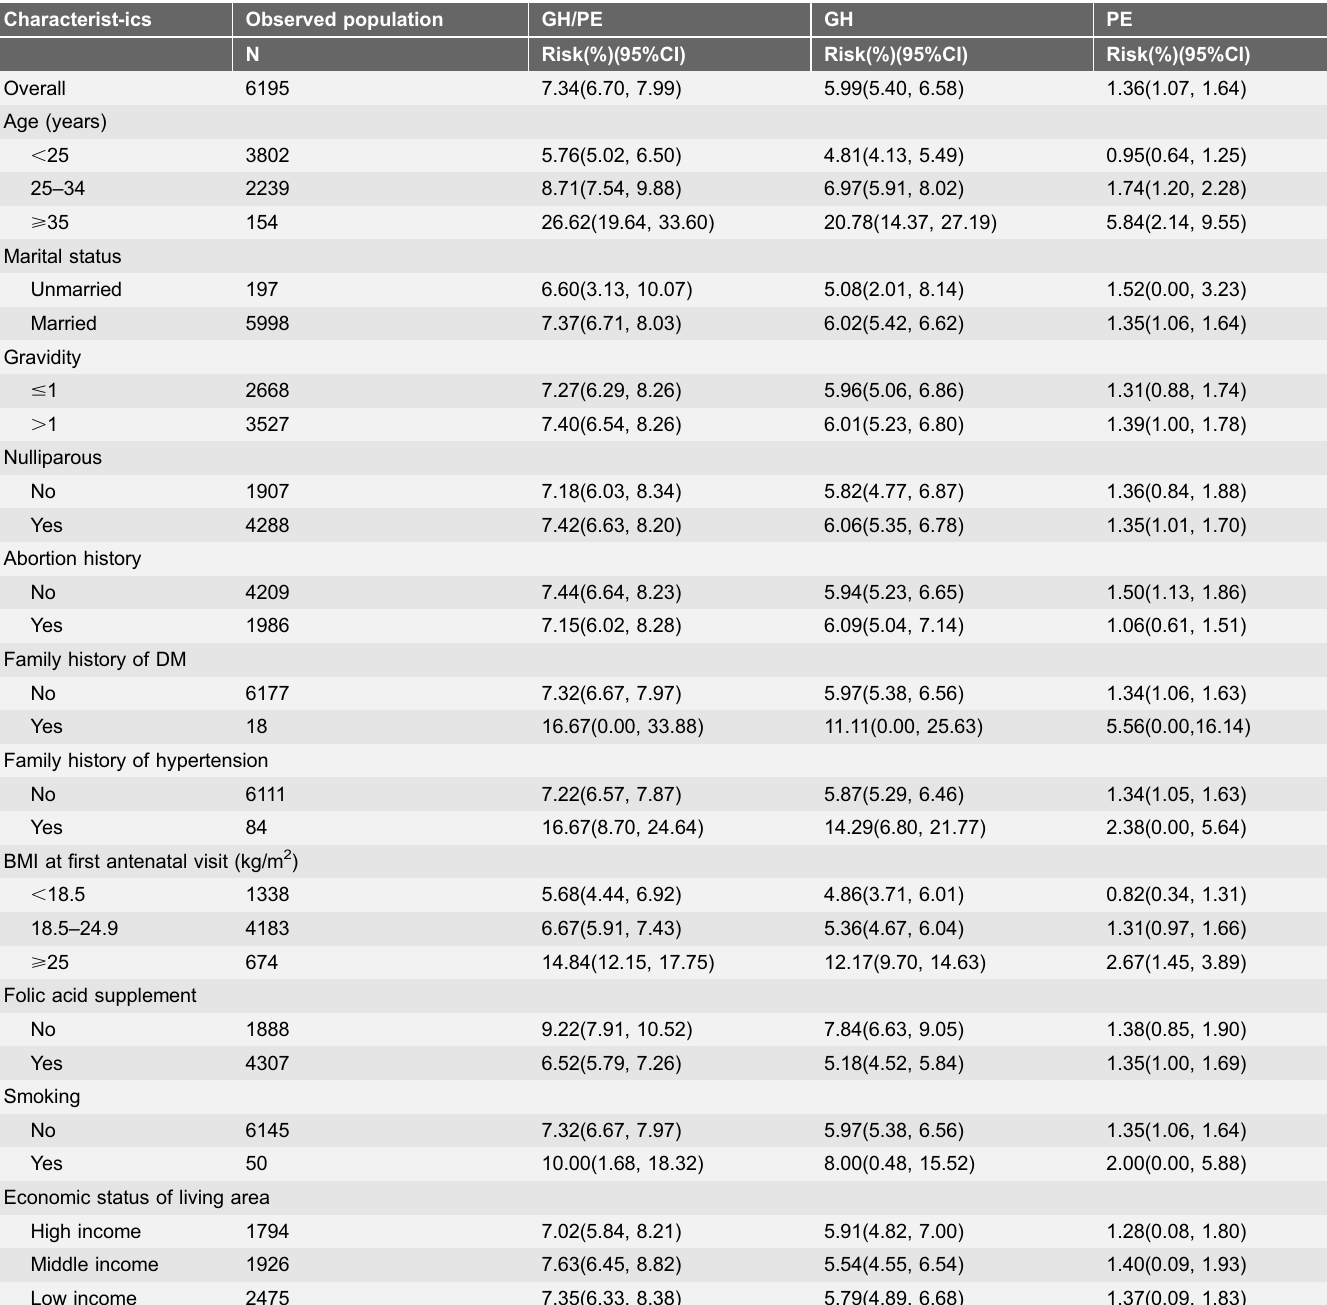
Table 2. Crude risks of pregnancy-induced hypertension by different maternal characteristics among pregnant women in Liuyang rural area, Hunan, China, 2012.